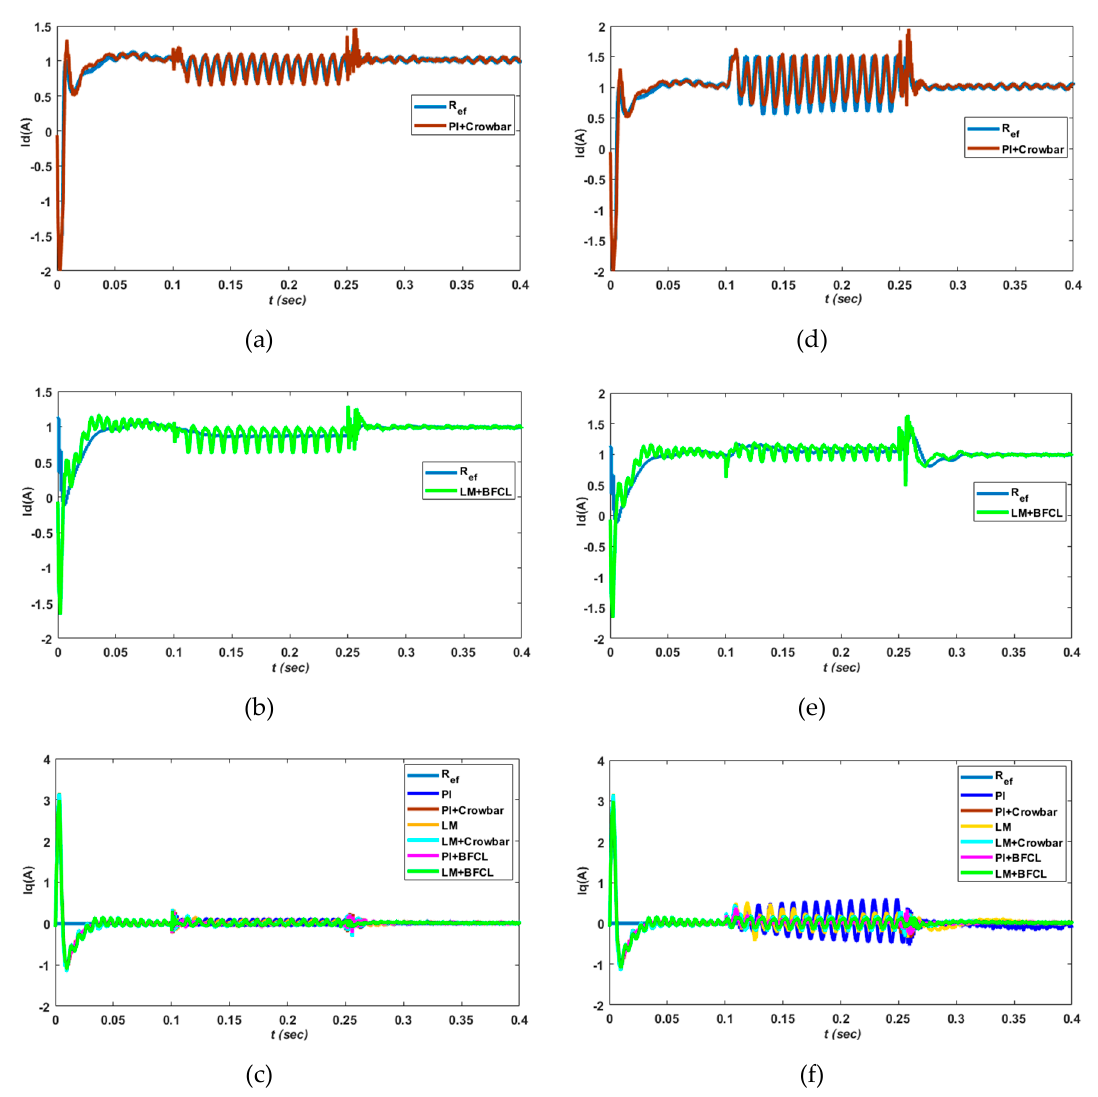
Figure 22. Active (Id) and reactive (Iq) current components during P-G ( a, b, c ) and P-P ( d, e, f ) at 5-km distance .